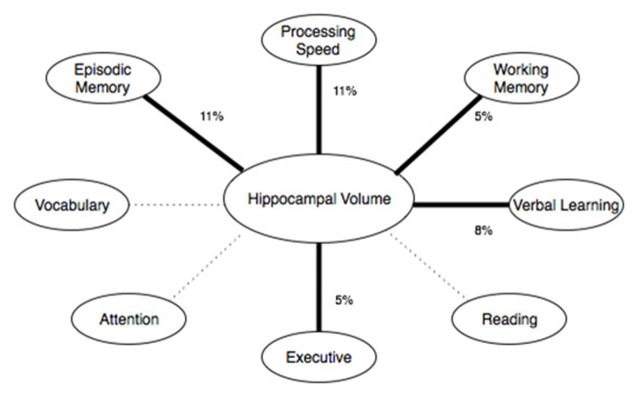
Shows the cognitive domains of the NIH toolbox and their relationship with hippocampal volume. Thick, solid lines represent significant (p < 0.05) effects. Dashed lines represent non-significant effects. The percentage represents the effect size (percent variance explained by the predictor variable).